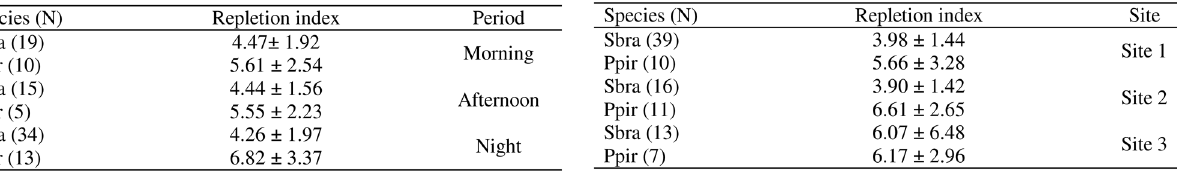
Table 2. Mean repletion index obtained for the two serrasalmin species of the rio de Contas, Bahia, collected during different periods of the day between May 2001 and April 2002. Values are the mean ± standard deviation.